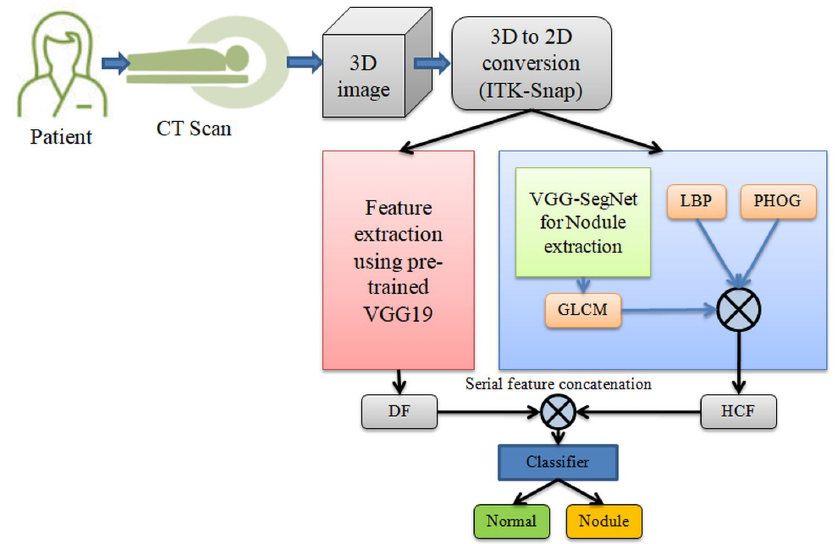
Figure 1. Structure of the proposed lung-nodule segmentation and classification system.